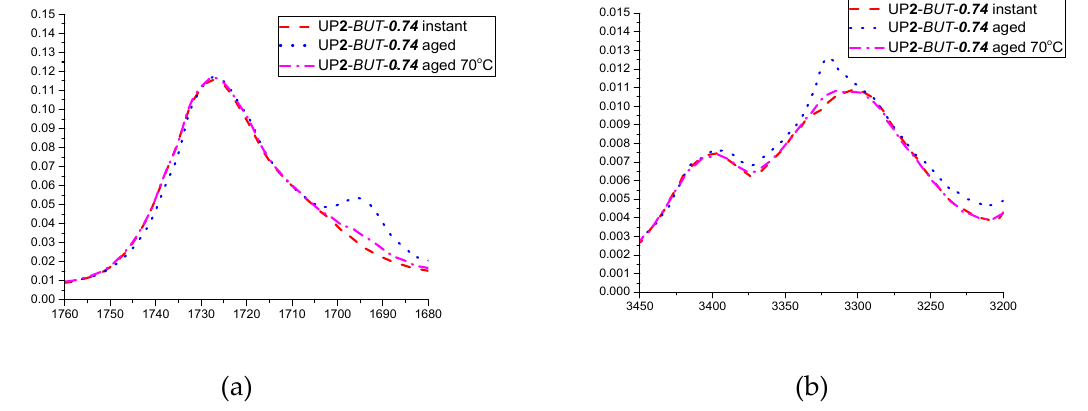
Figure 6. ATR-FTIR spectra at the C=O stretching band ranging 1680–1760cm − 1 ( a ), and the N–H stretching band ranging 3200–3450 cm − 1 ( b ): UP 2 - BUT - 0.74 instant was measured soon after production; UP 2 - BUT - 0.74 aged was measured after one month; UP 2 - BUT - 0.74 aged 70 °C was measured after UP 2 - BUT - 0.74 aged was reheated to 70 °C.